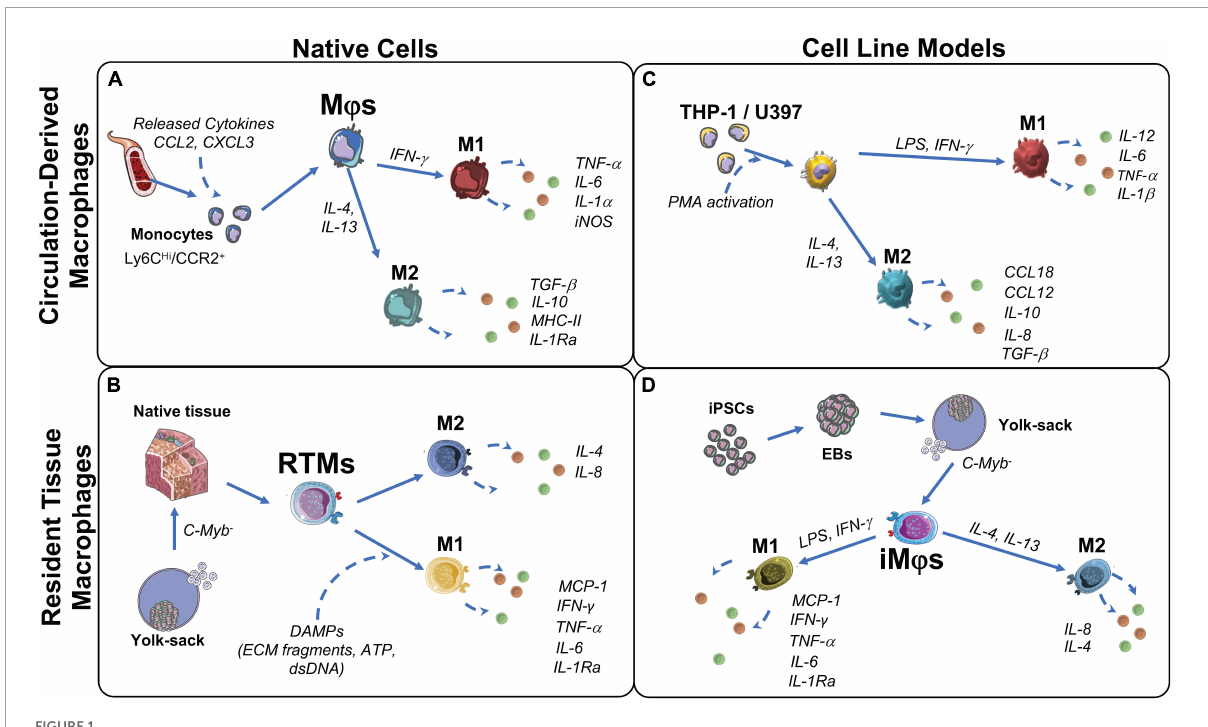
FIGURE1 Origin and function of macrophages and their corresponding cell models. (A) Circulation-derived monocytes (CD14 Hi /CCR2 + ), activated by C-C motif chemokine ligand 2 (CCL2) and C-X-C chemokine ligand 3 (CXCL3) from cells at the wound site, differentiate to macrophages (M ϕ s). When in contact with cell debris and ECM fragments, M ϕ s polarize to M1 to induce clearance of the damaged cells/proteins. M1- M ϕ s secrete pro-inflammatory factors to attract ECM producing stromal cells and restore tissue integrity. Over time, to resolve inflammation, M ϕ s polarize to M2. M2-M ϕ s secrete anti-inflammatory factors that favor remodeling and restore tissue integrity. (B) Resident tissue macrophages (RTMs) are derived from C-Myb − hematopoiesis in the yolk-sac and reside in native fetal tissues, but persists into adulthood. Upon tissue damage, RTMs are activated by damage associated molecular patterns (DAMPs) and polarize to M1. M1-RTMs secret pro-inflammatory cytokines that recruit circulating monocytes and neutrophils, but then quickly polarize to the M2 state to promote tissue restoration and homeostasis. (C) Immortalized leukemic cells THP-1 and U937 are used to model peripheral blood-derived monocytes and M ϕ s. M1 polarization is induced by lipopolysaccharides (LPS), interferon (IFN)- γ with subsequent pro-inflammatory cytokine production interleukin (IL)-12, IL-6, IL-1 β , and tissue necrosis factor (TNF)- α . M2 polarization is induced by IL-4 and IL-13 with subsequent production of IL-10, IL-8, CCL18, CCL12 and transforming growth factor (TGF) β . (D) iM ϕ s are a proposed model of RTMs in vitro . Their C-Myb independent ontogeny is similar to RTMs and have shown to polarize in a similar manner to the M1 (LPS, IFN- γ ) and M2 (IL-4, IL-13) states. EB, embryoid body; iNOS, inducible nitric oxide synthase; iPSCs, induced pluripotent stem cells; LPS, lipopolysaccharides; MCP-1, monocyte chemoattractant protein 1; MHC-II, major histocompatibility complex class II; PMA, protein kinase C